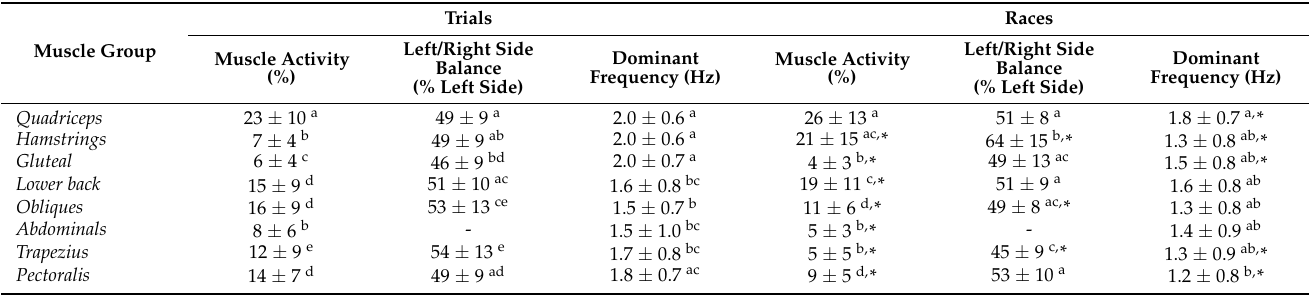
Table 5. Mean ( ± SD) surface EMG parameters of eight muscle groups for jockeys ( n = 12) riding in trials ( n = 48) and races ( n = 16).